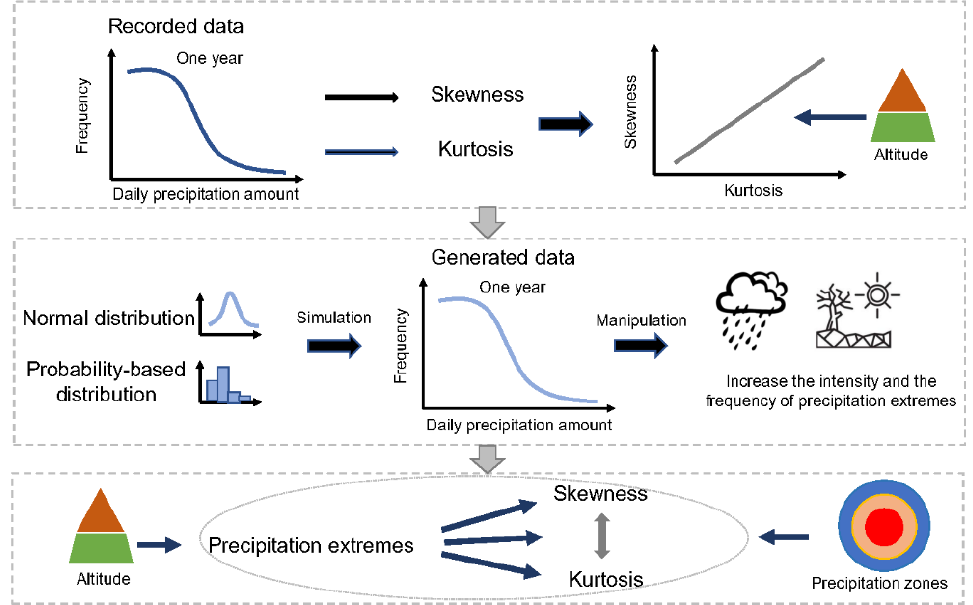
Figure 2. The conceptual graph of this study. First, the relationships between the skewness and kurtosis of the annual precipitation distributions were analyzed based on recorded weather data (upper grey dotted box). Second, statistical models were used to simulate the effects of precipitation extremes on the skewness and kurtosis (middle grey dotted box). Third, environmental conditions were considered in terms of the response of skewness–kurtosis interactions to precipitation extremes (lower grey dotted box).